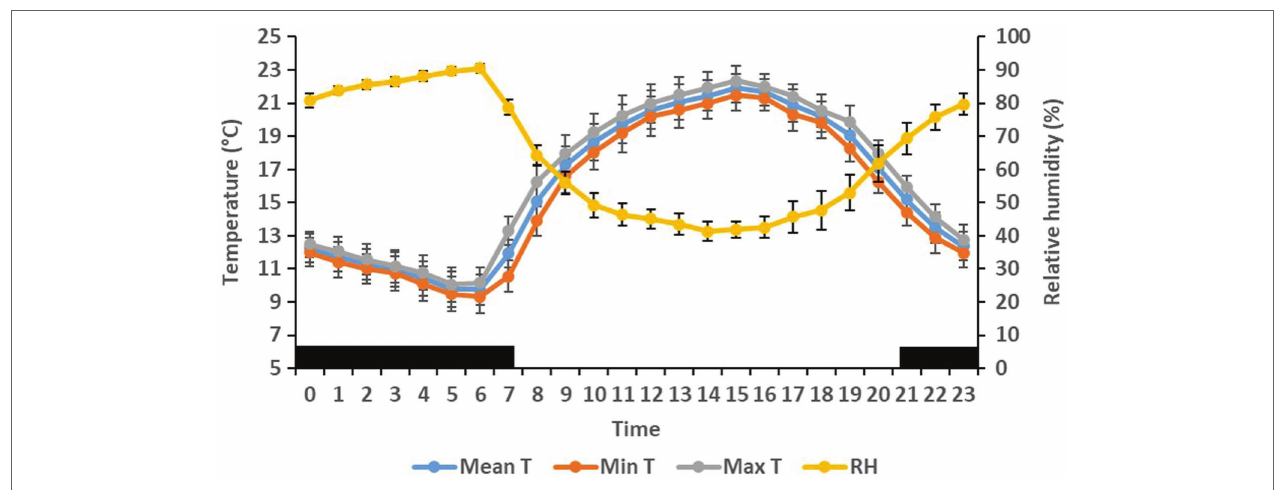
FIGURE 1 | Mean (±SEM) maximum (Max), minimum (Min), mean ambient temperature (T, ° C), and relative humidity (RH, %) on the farm in which six cows were exposed to low and high density